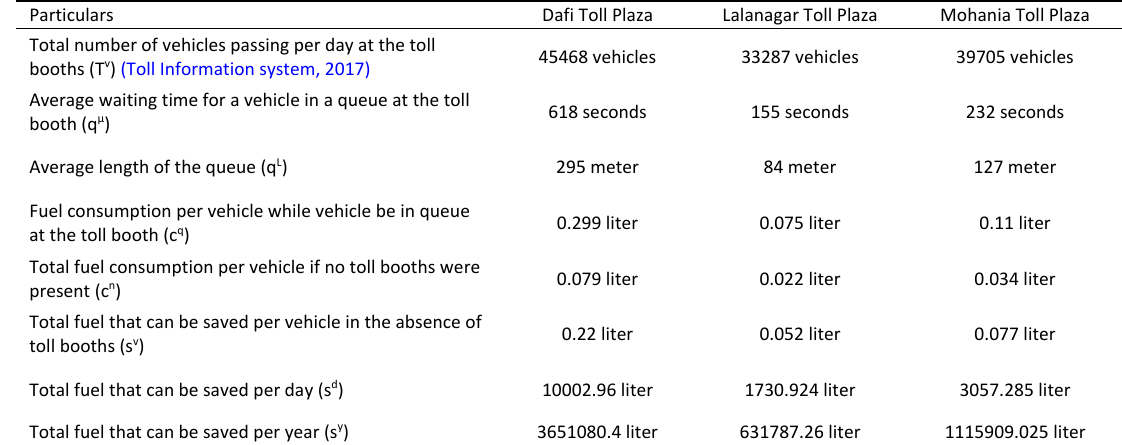
Table 2: Fuel consumption and amount of fuel wastage at the three toll booths Particulars Dafi Toll Plaza